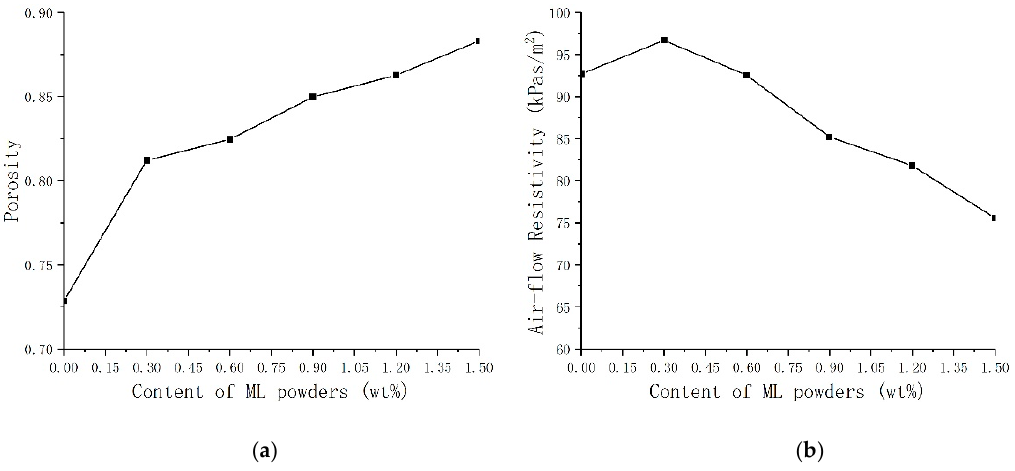
Figure 13. Porosity ( a ) and air-flow resistivity ( b ) of TOPUF adding different mass of ML powders.